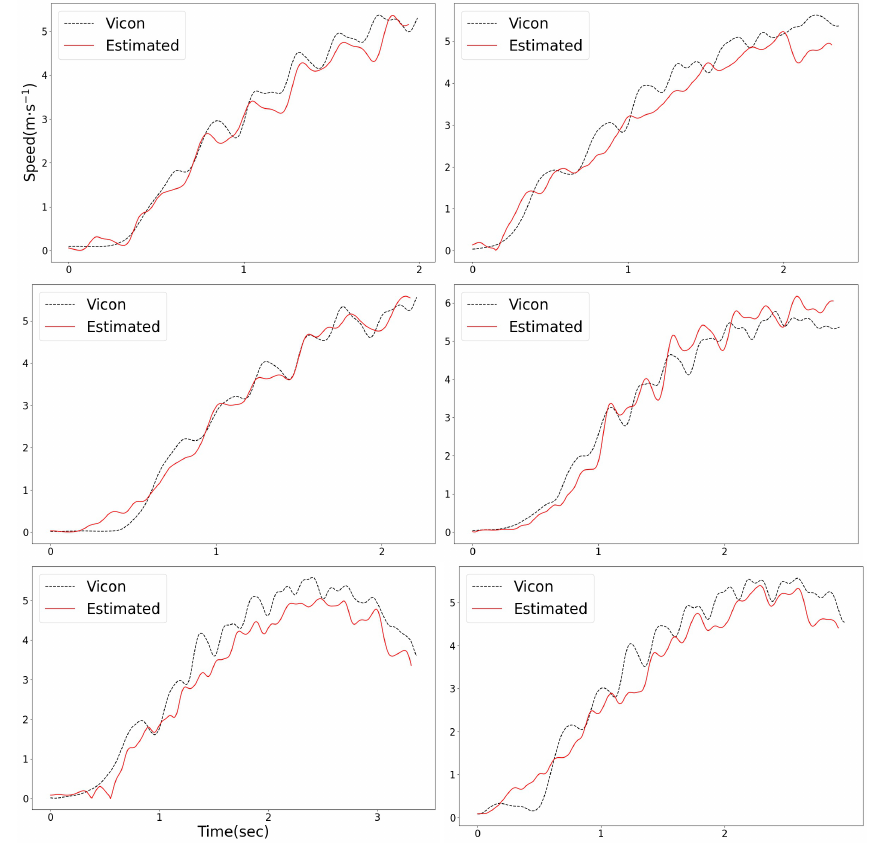
Figure 26. The 2D speed of the athlete: comparison with Vicon data.